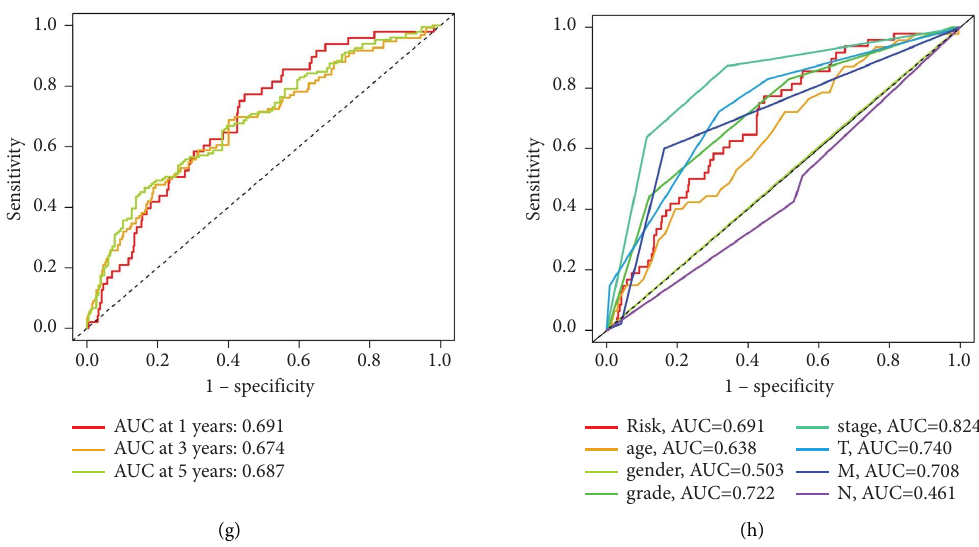
Figure 3: (a) Te univariate COX regression analysis based on the OS of RCC patients. (b) Survival analysis between low- and high- expression of ALOX5 groups. (c) Te survival analysis between low- and high-expression of CCND1 groups. (d) Te survival analysis between low- and high-expression of NR3C2 groups. (e) Te survival analysis between low- and high-expression of PTGER3 groups. (f) Te survival analysis between low- and high-risk groups. (g) Te clinical-related ROC curve demonstrated the predictive value of clinical characteristics and risk score. (h) Te time-dependent ROC curve demonstrated the predictive value of prognostic prediction